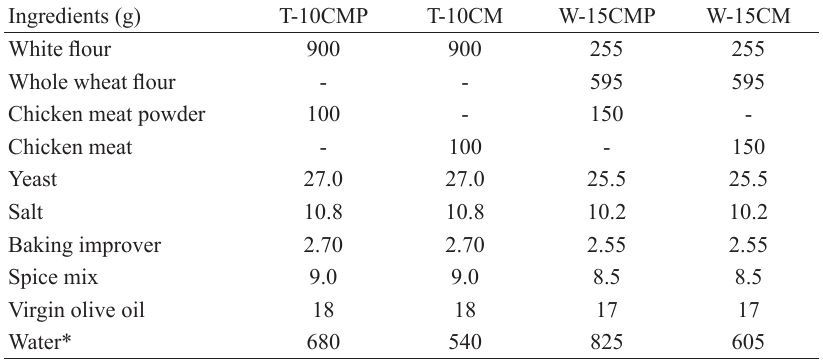
Enriched baguette bread formulations.